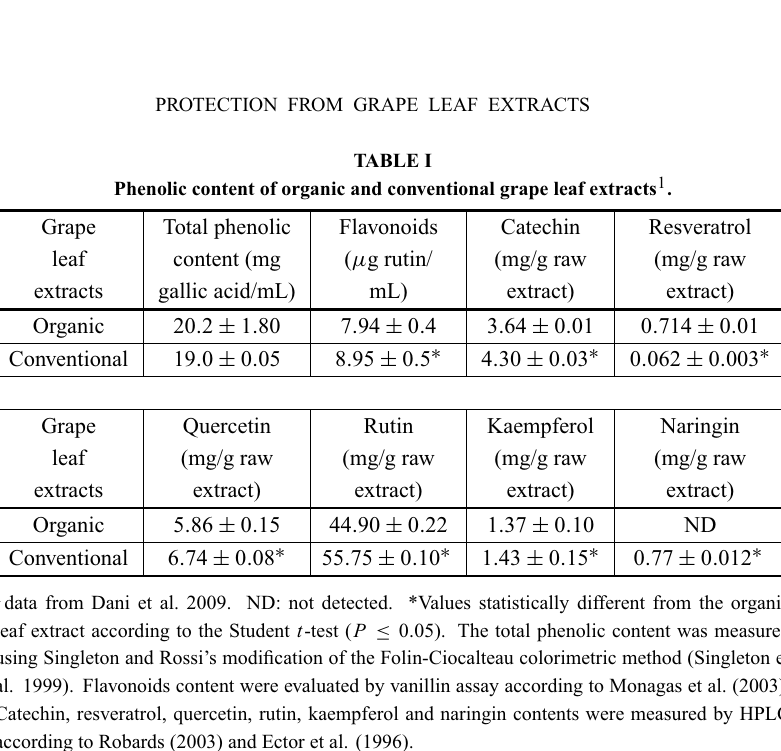
1 data from Dani et al. 2009. ND: not detected. *Values statistically different from the organic leaf extract according to the Student t -test ( P ≤ 0 . 05). The total phenolic content was measured using Singleton and Rossi’s modification of the Folin-Ciocalteau colorimetric method (Singleton et al. 1999). Flavonoids content were evaluated by vanillin assay according to Monagas et al. (2003). Catechin, resveratrol, quercetin, rutin, kaempferol and naringin contents were measured by